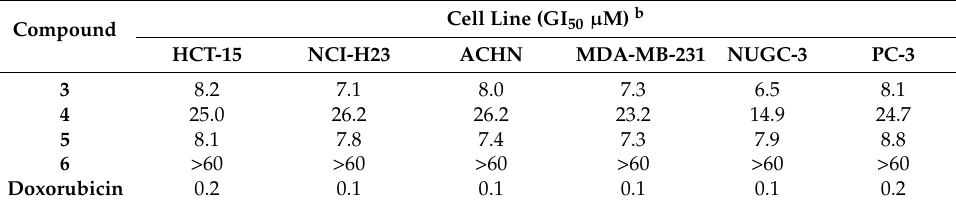
Table 3. Growth inhibition by compounds 3 – 6 against a panel of human tumor cell lines a .